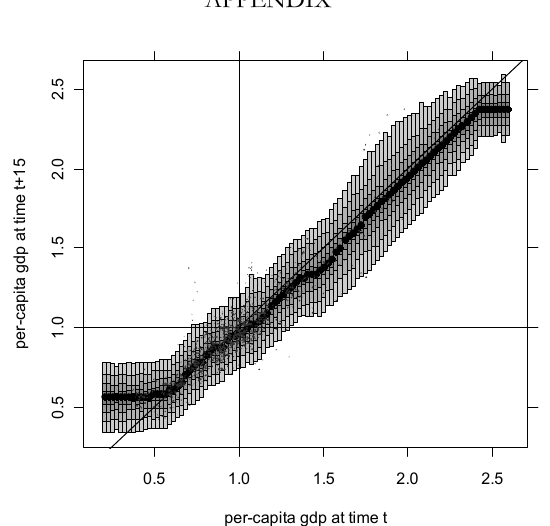
Figure A1 – Intra-Distribution Dynamics of regional per-capita income in Europe. HDR plot of conditional density for transitions of 15 years between 1980-2002. Groningen is ex- cluded from the sample.